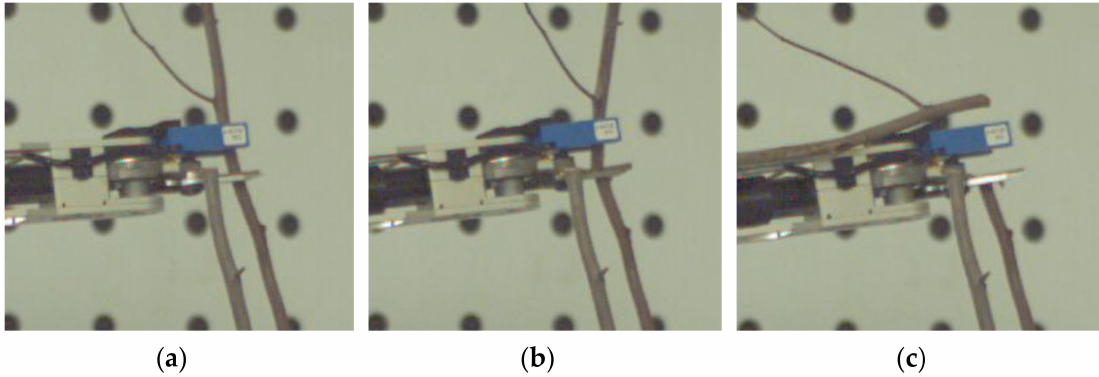
Figure 16. The whole process of the successful pruning of the manipulator. ( a ) The start of the pruning process; ( b ) during the pruning process; and ( c ) the branch has been